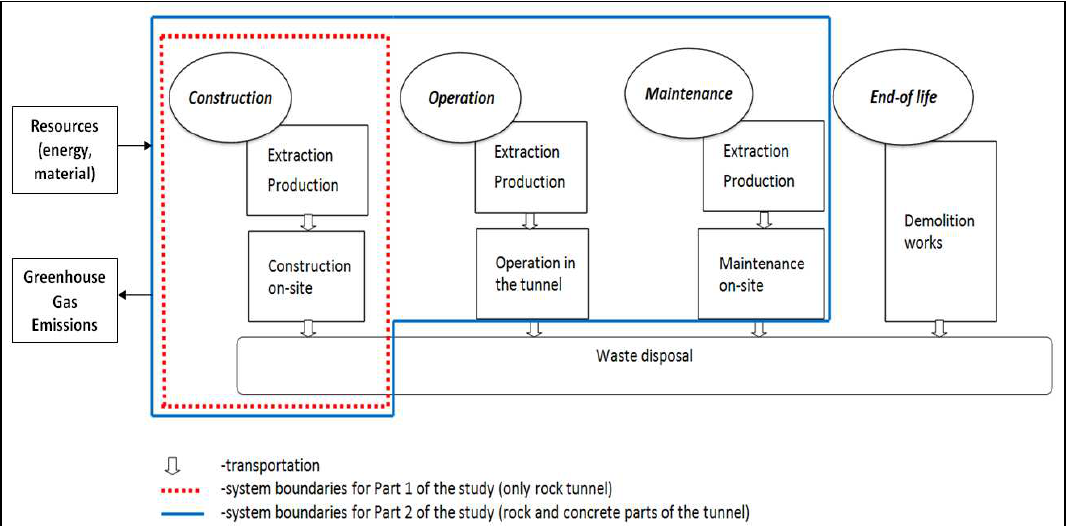
Figure 2. System boundaries for the two parts of the